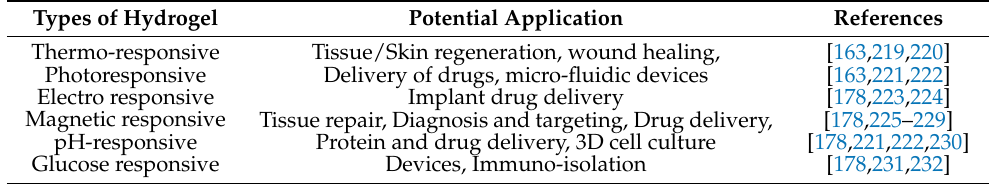
Table 6. Hydrogel applications overview. Types of